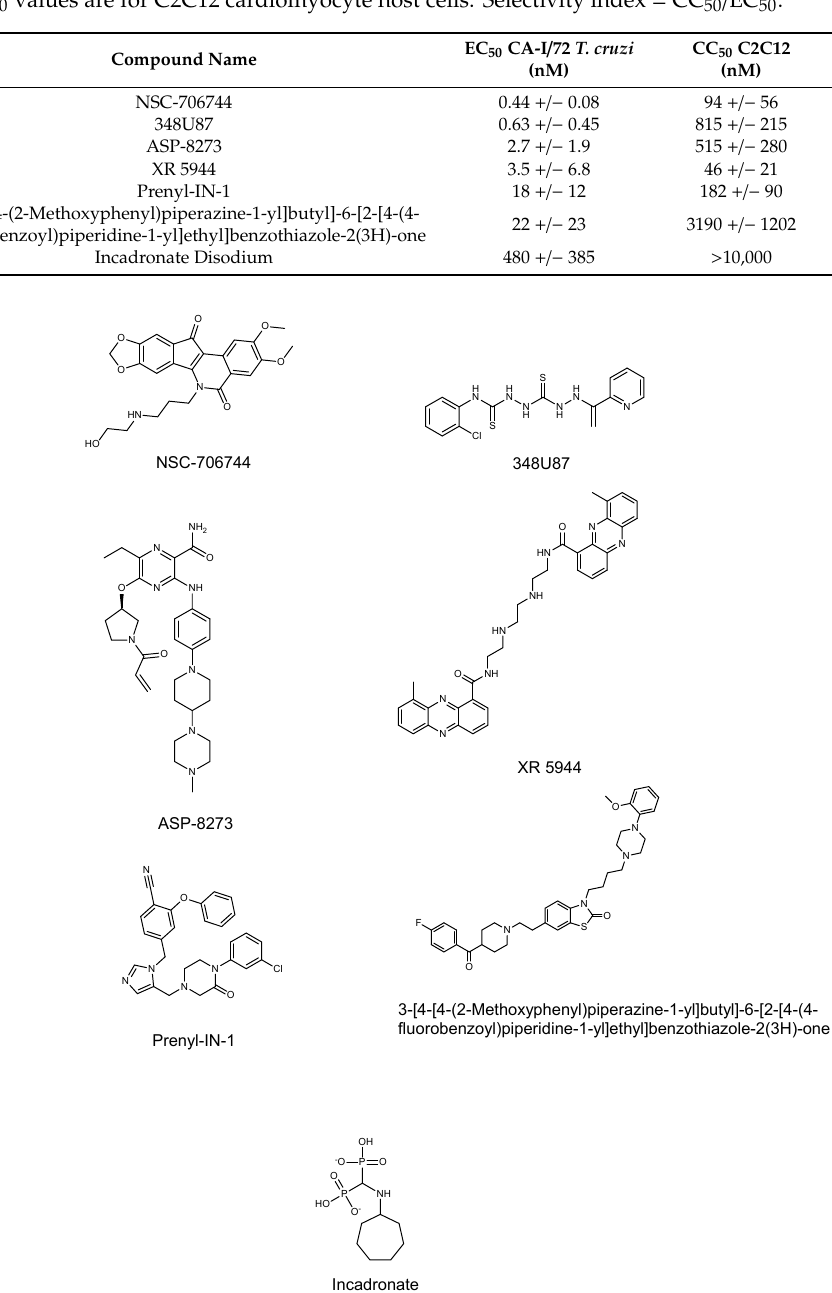
Table 1. EC 50 and CC 50 values for 7 validated hits from the ReFRAME library against CA-I / 72 T. cruzi in the phenotypic high-content imaging assay, ranked in order of potency. Values were calculated from duplicate dose response data, +/ − standard error (SE). EC 50 values are for T. cruzi CA-I / 72 parasites.